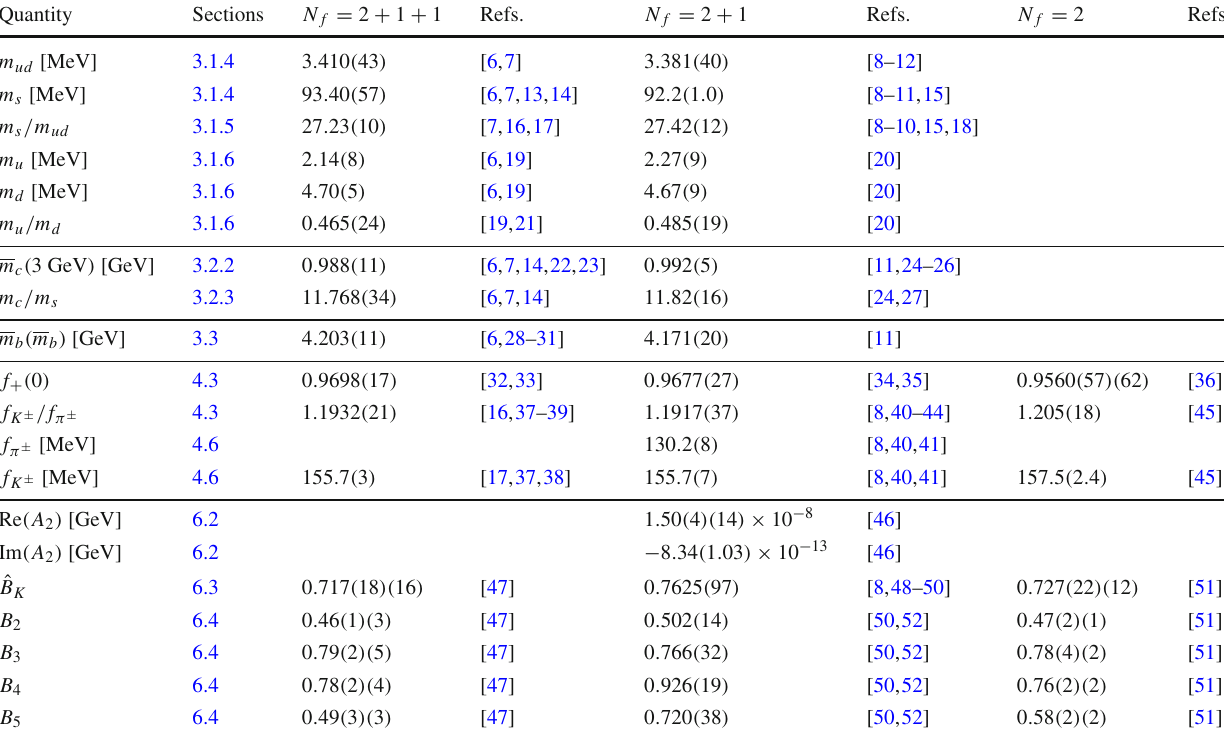
Table 1 Summary of the main results of this review concerning quark masses, light-meson decay constants, and hadronic kaon-decay and kaon- mixing parameters. These are grouped in terms of N f , the number of dynamical quark flavours in lattice simulations. Quark masses are given in the MS scheme at running scale μ = 2GeV or as indicated. BSM bag parameters B 2 , 3 , 4 , 5 are given in the MS scheme at scale μ = 3GeV. Further specifications of the quantities are given in the quoted sections. Results for N f = 2 quark masses are unchanged since FLAG 16 [3], and are